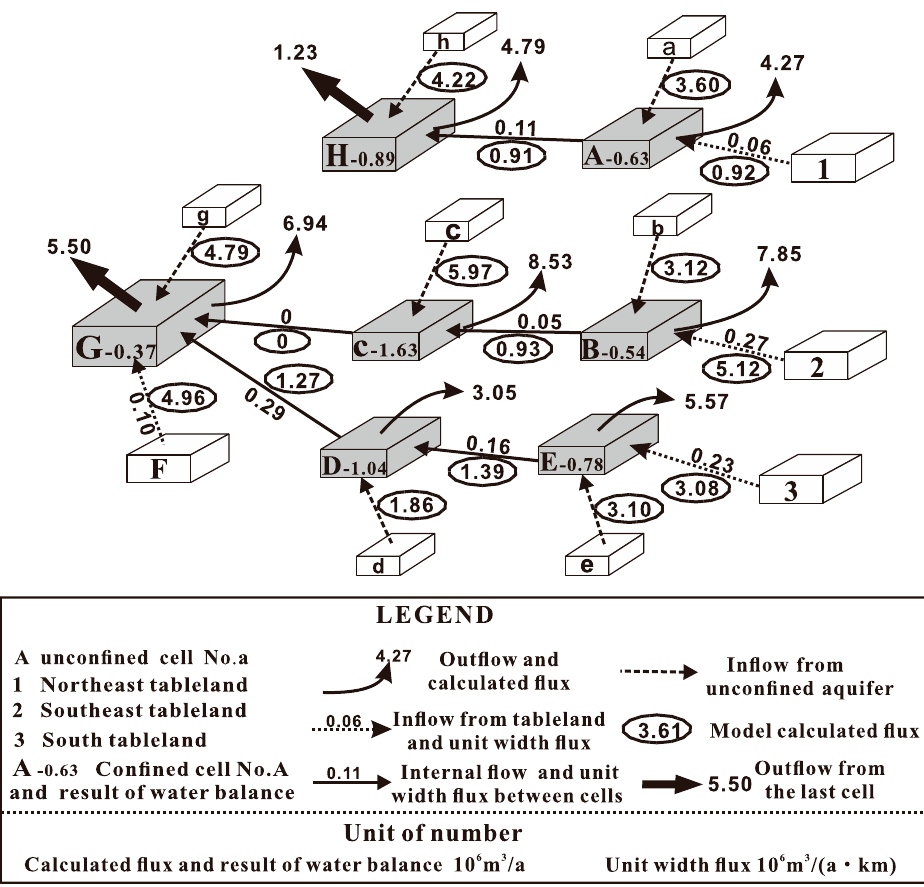
Figure 12. Quantitative water circulation model of the confined aquifer cells.